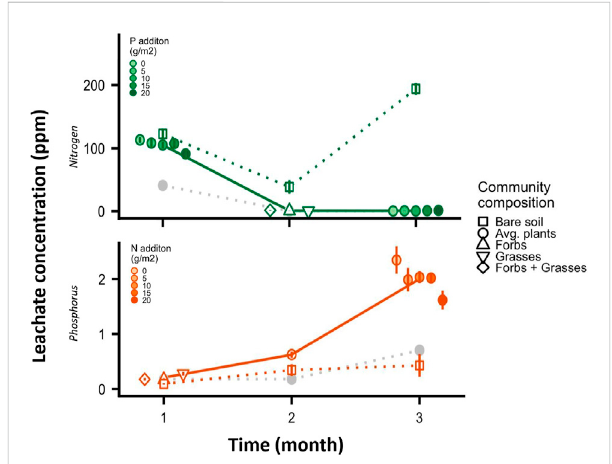
FIGURE 2 Average concentration by time of nitrogen and phosphorus in leachate, for N losses with increasing P addition and P losses with increasing N addition. Temporal patterns for bare soil mesocosms (square points) and nutrient control mesocosms (grey points, 0 g N m − 2 and 0 g P m − 2) are shown for comparative purposes.